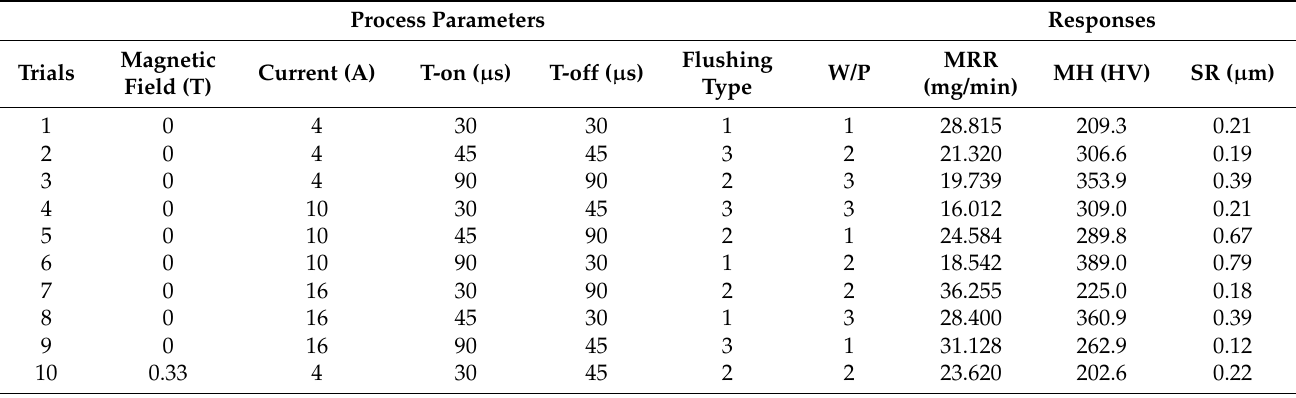
Table 3. Experimental Factors and